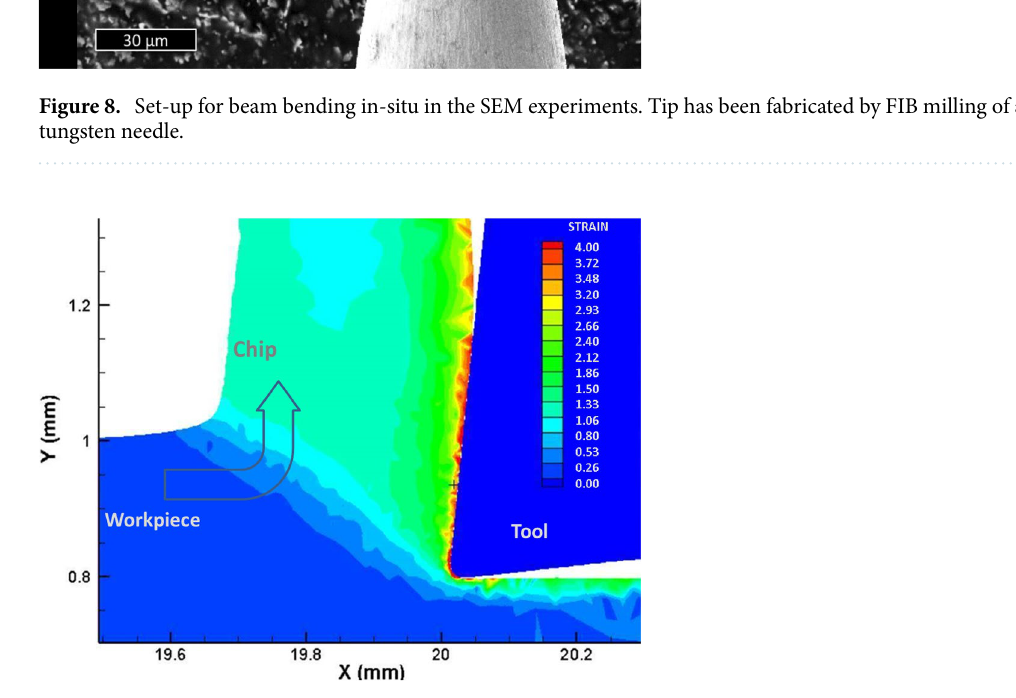
Figure 9. Calculations of the strain in workpiece and chip for a AISI 1045 steel cut at 200 m/min and uncut chip thickness of 0.2